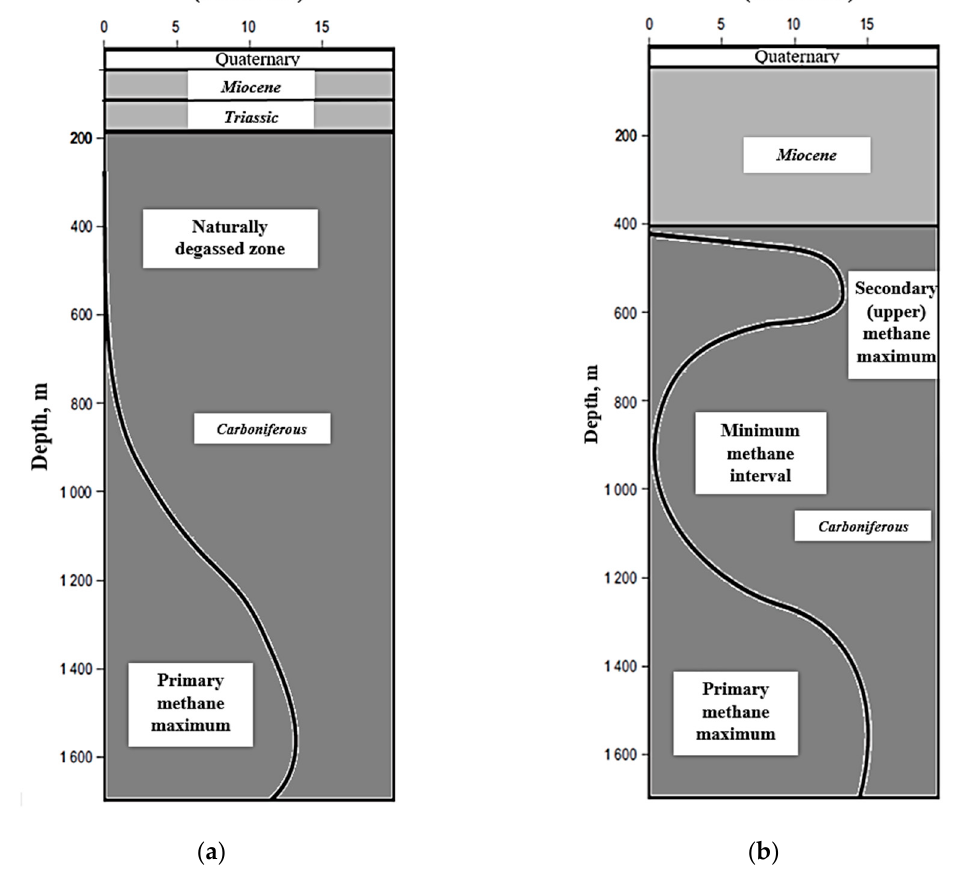
Figure 3. The model distributions of methane content in hard coal seams in the northern parts of Upper Silesian Coal Basin ( a ) and the southern parts of Upper Silesian Coal Basin ( b ) (own study based on [35)].